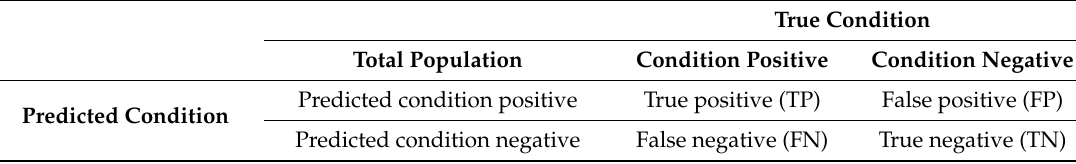
Figure 4. Cross-validation method. Dataset was divided into two subsets, the training set and the test set. In our case, every experiment was carried out 10 times (10-fold) and the final performance was calculated as the average of the 10 performances. Table 2. Definition of confusion matrix.